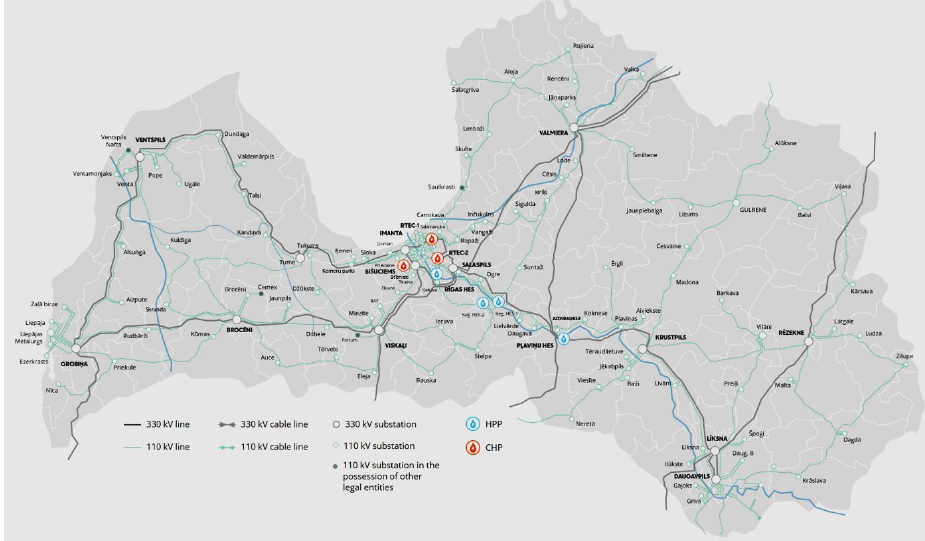
Fig. 2. Latvian transmission network